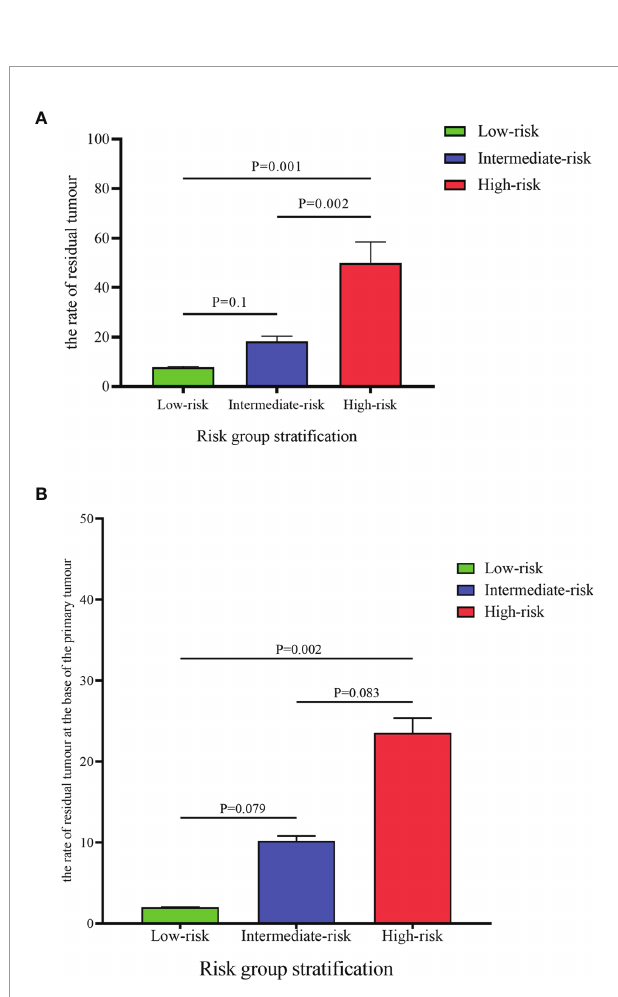
FIGURE 1 | Comparison of the rate of residual tumour (A) and the rate of residual at the base of the primary tumour (B) between different risk groups.